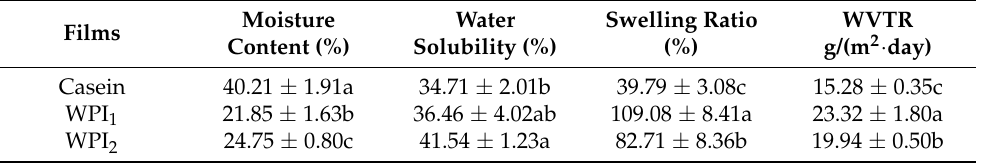
Table 2. Hydrodynamic properties of milk protein based edible films 1